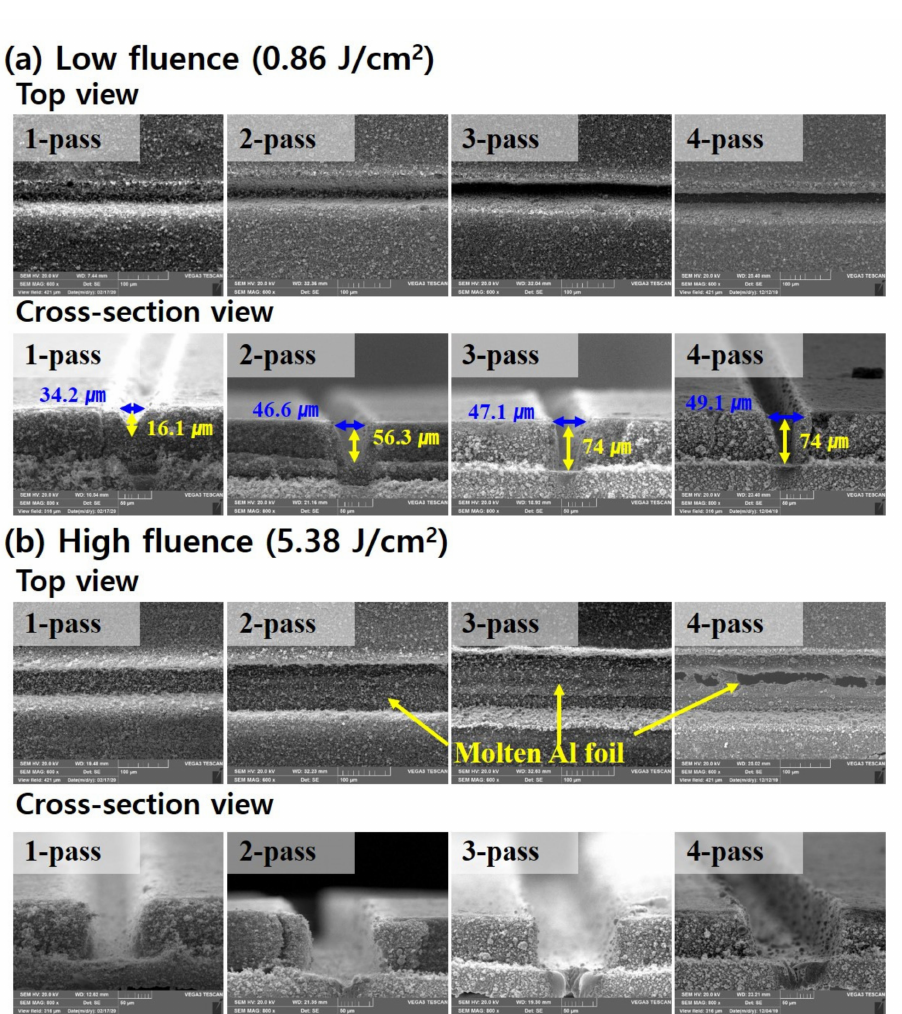
Figure 5. SEM images of laser-structured LiFePO 4 cathode with ( a ) Low fluence (0.86 J/cm 2 ); ( b ) high fluence (5.38 J/cm 2